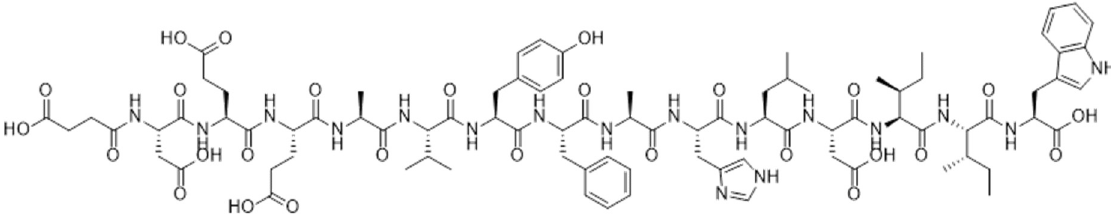
Figure 1. Chemical structure of sovateltide.( Adapted with permission from MedKoo Biosciences, Inc. © MedKoo Biosciences, Inc. https://www.medkoo.com/products/34963, accessed on 10 March 2022).